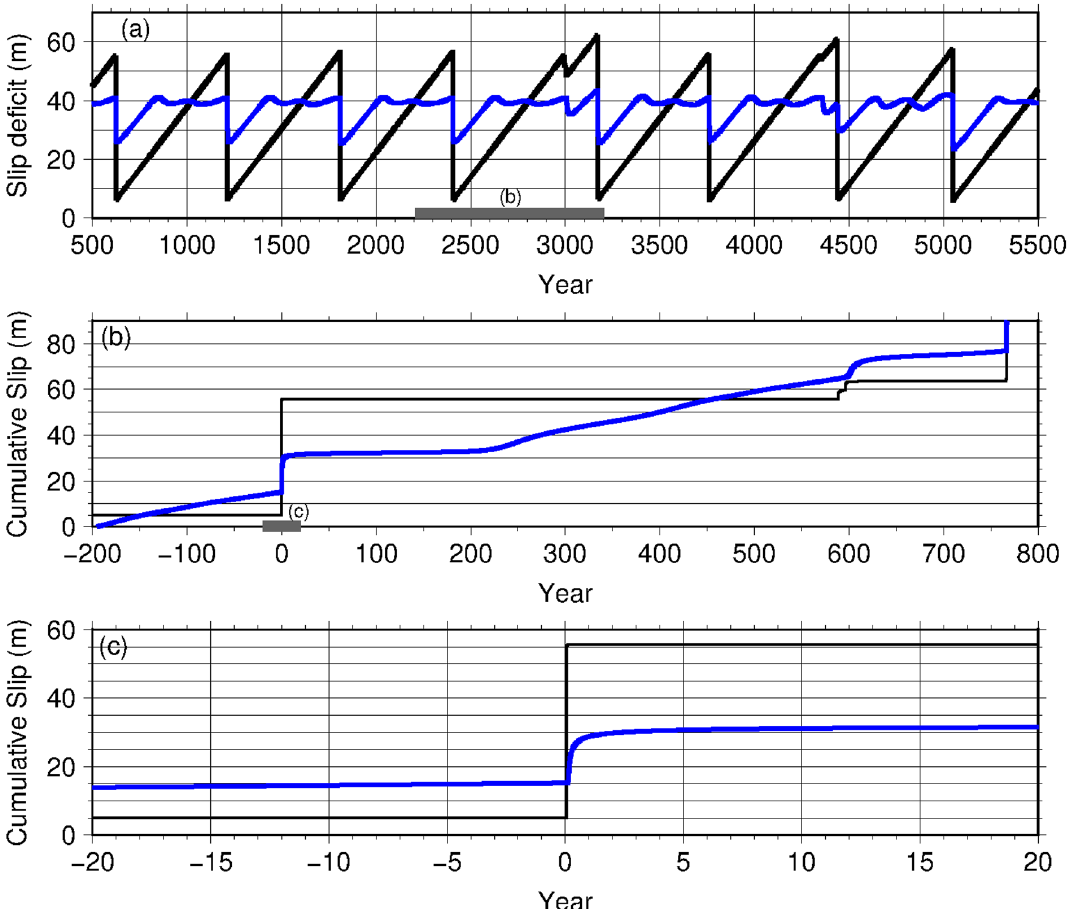
Figure 4. ( a ) Temporal distribution of slip deficits at the point within the M9 source area (black) and southern segment (blue) at the locations of the crosses shown in Fig. 5 over 5000 years for Model B3. Thick, grey line indicates the period shown in ( b ). ( b , c ) Temporal variation of the cumulative slip at the point within the M9 source area (black) and southern segment (blue) at the locations of the crosses shown in Fig. 5. ( b ) 200 years before and 800 years after the M9 earthquake obtained for Model B3. Thick, grey line indicates the period shown in ( c ). ( c ) 20 years before and after each M9 earthquake obtained for Model